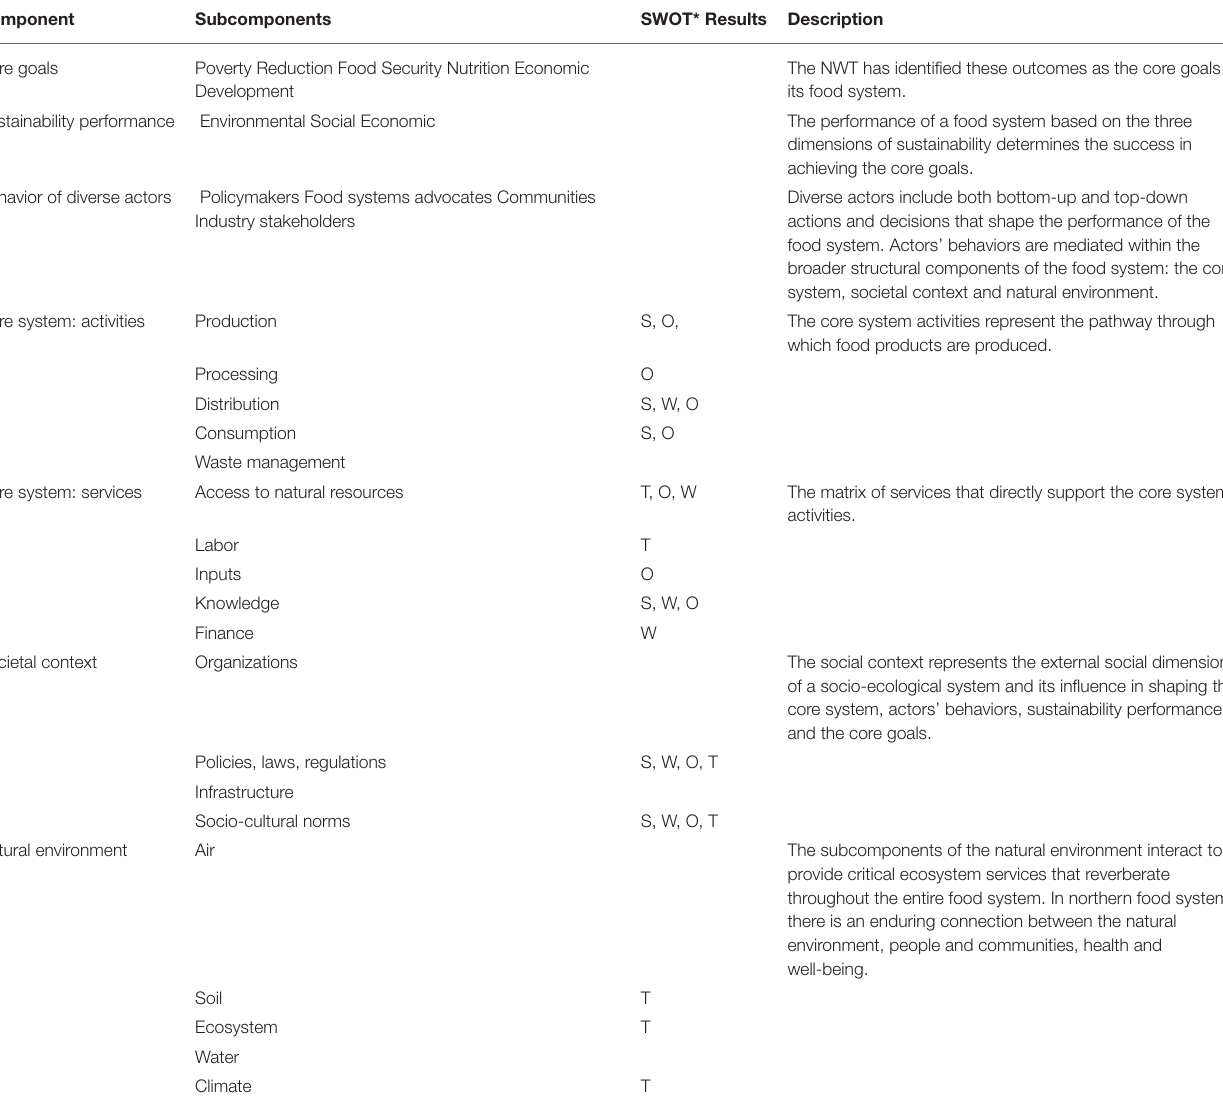
TABLE 1 | Description of each component (ring) and its associated subcomponents of the adapted food systems framework ( Figure 1 ) with SWOT